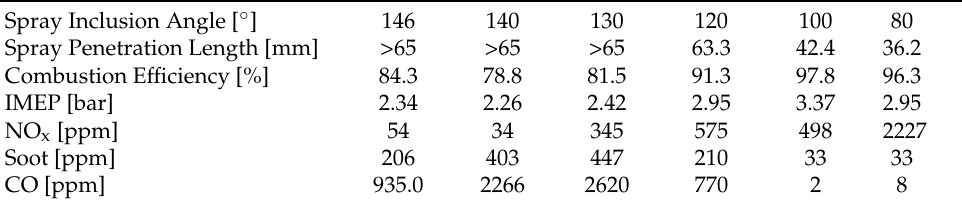
Table 7. Effect of spray inclusion angle on spray, combustion characteristics, and engine-out emissions. Spray Inclusion Angle [ ◦